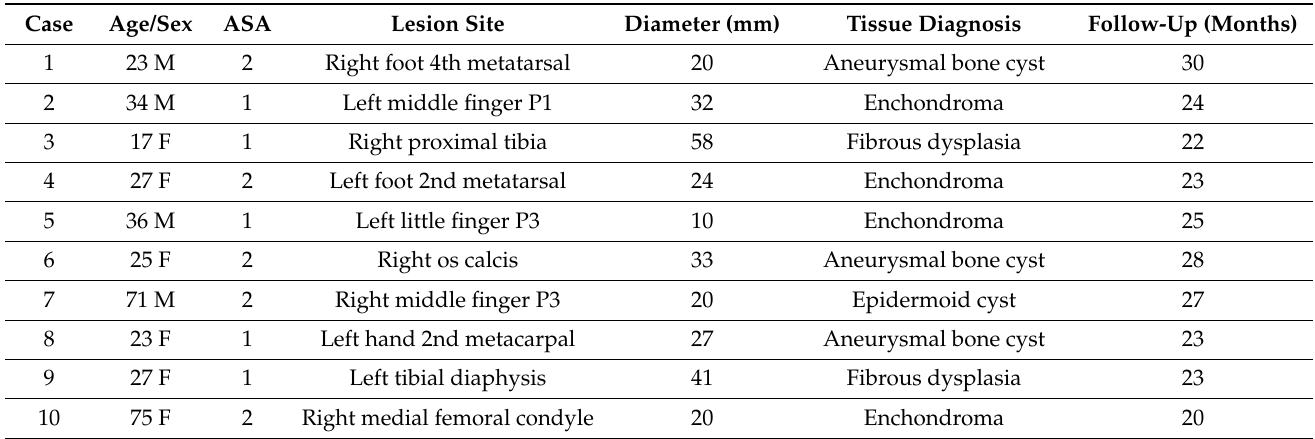
Table 1. Clinical details of patients managed with GeneX.